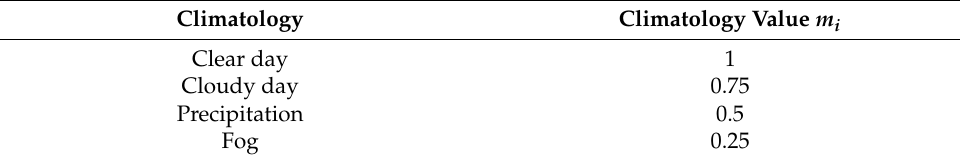
Table 2. Climatology coefficient values [4].